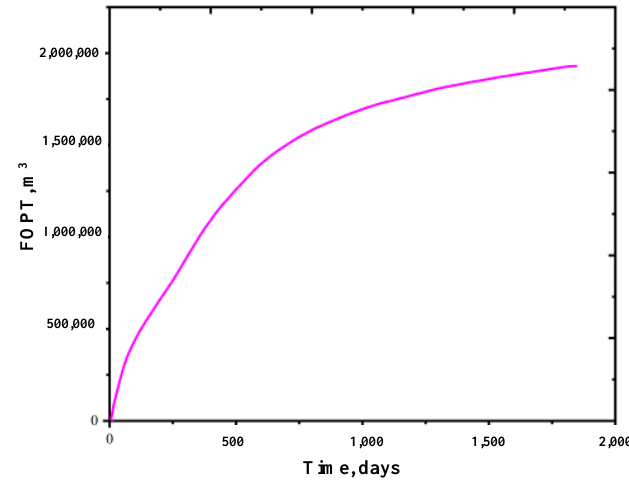
Figure 8. Field oil production total for horizontal wells.